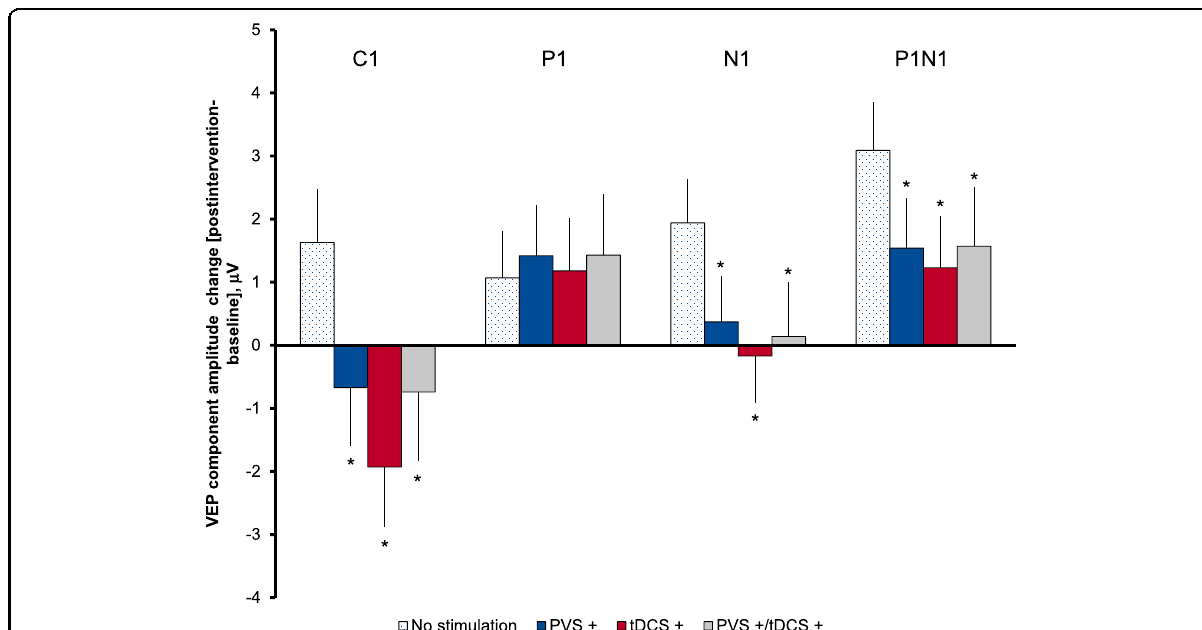
Fig. 2 Postintervention VEP component amplitude change [postintervention-baseline] depending on condition. All amplitudes were measured in component direction for better comparability (i.e., amplitudes of negative-going components are positive). It is to note, that the estimated coef fi cients as given by the linear mixed effects models need to be added to each other to get the overall estimation of effect sizes for a speci fi c stimulation type. For example, for the stimulation condition PVS, the respective coef fi cient for PVS + needs to be added to the coef fi cient for “ no stimulation. ” To correctly display the in fl uence of combined stimulation, the coef fi cients of “ no stimulation ” , PVS + , tDCS + , and the additional coef fi cient for the PVS/tDCS interaction needs to be summed up. While all VEP components are estimated to slightly increase in the absence of stimulation in the linear mixed effects models, both experimental conditions displayed signi fi cantly different effects. Mainly, C1 amplitudes decreased after PVS, tDCS, and combined stimulation. N1 increased, but to a signi fi cantly smaller degree than without stimulation after PVS and combined stimulation and decreased following tDCS. P1N1 peak-to-peak difference increased following all conditions, but to a signi fi cantly smaller amount following tDCS and combined stimulation than estimated for the absence of stimulation. Combined stimulation in general displayed effect seizes similar to the single stimulation conditions and did not reach levels as expected for additive effects. VEP, visually evoked potential; PVS + , sum of coef fi cients for prolonged visual stimulation and “ no stimulation ” ; tDCS + , sum of coef fi cients for transcranial direct current stimulation and “ no stimulation ” , PVS + /tDCS + , sum of coef fi cients for PVS + , tDCS + , PVS/tDCS interaction and “ no stimulation ” ; β -coef fi cients ± SE. Asterisk indicates signi fi cant difference in amplitude changes following the stimulation condition compared to “ no stimulation ” (signi fi cant coef fi cient in linear mixed effects